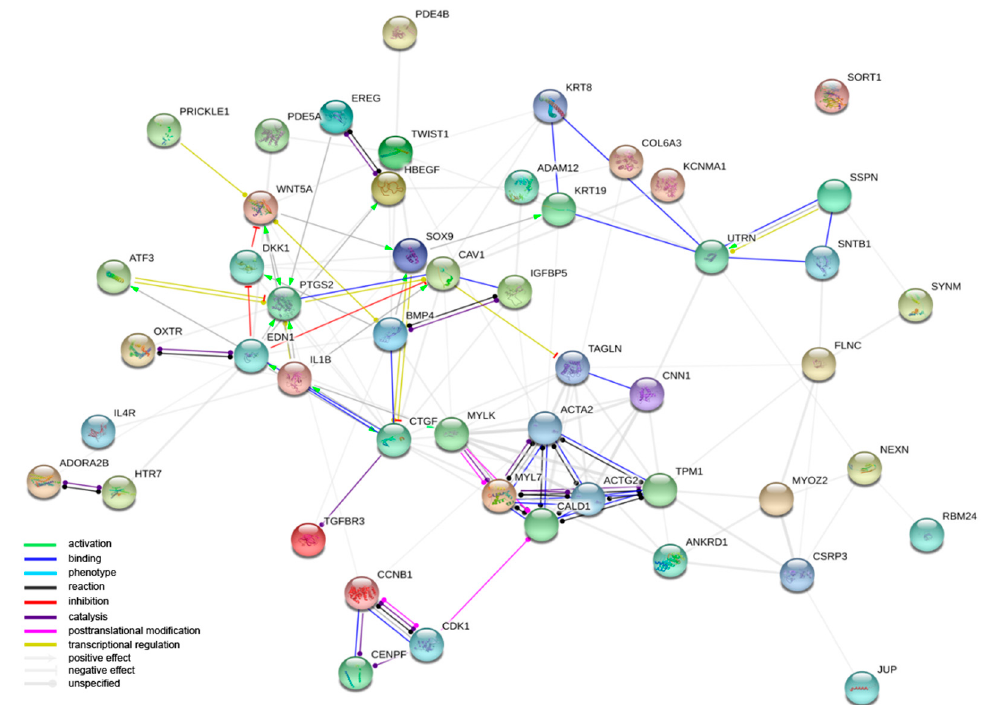
Figure 3. Interaction network of proteins encoded by the 50 most changed DEGs belonging to “muscle cell development”, “muscle cell differentiation”, “muscle contraction”, “muscle organ development”, “muscle organ morphogenesis”, “muscle structure development”, “muscle system process” and “muscle tissue development” GO BP terms. The network was generated by STRING software. Network nodes represent proteins. Empty nodes indicate proteins of unknown 3D structure.